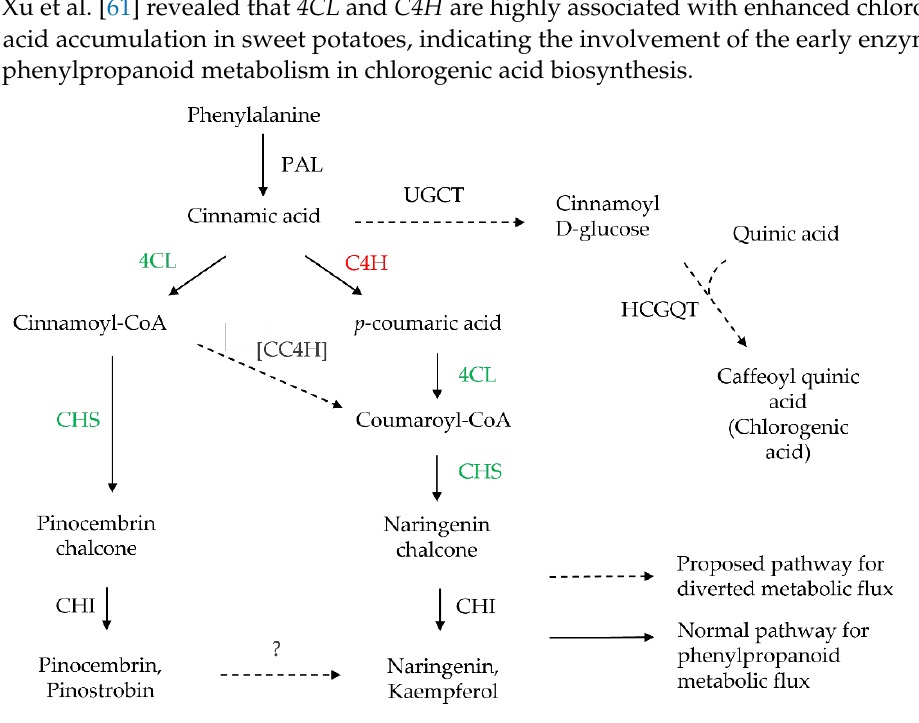
Figure 6. The proposed biosynthesis pathway of flavonoid in the C4H -silenced cells of Nicotiana tabacum. The dotted arrows show the potential diversion of metabolic flux. Alphabet in red indicates reduced expression, whereas alphabet in green indicates enhanced gene expression. PAL, phenylalanine ligase; C4H, cinnamate-4-hydroxylase; 4CL, 4-coumarate ligase; CHS, chalcone synthase; CHI, chalcone isomerase; UGCT, UDP-glucose:cinnamate glucosyltransferase; HCGQT, hydroxycinnamoyl glucose:quinate hydroxycinnamoyl transferase; CC4H, cinnamoyl-CoA 4-hydroxylase. The enzymes for 4-hydroxylation of cinnamoyl-CoA have not been demonstrated yet. Hence, CC4H is indicated in brackets showing their potential